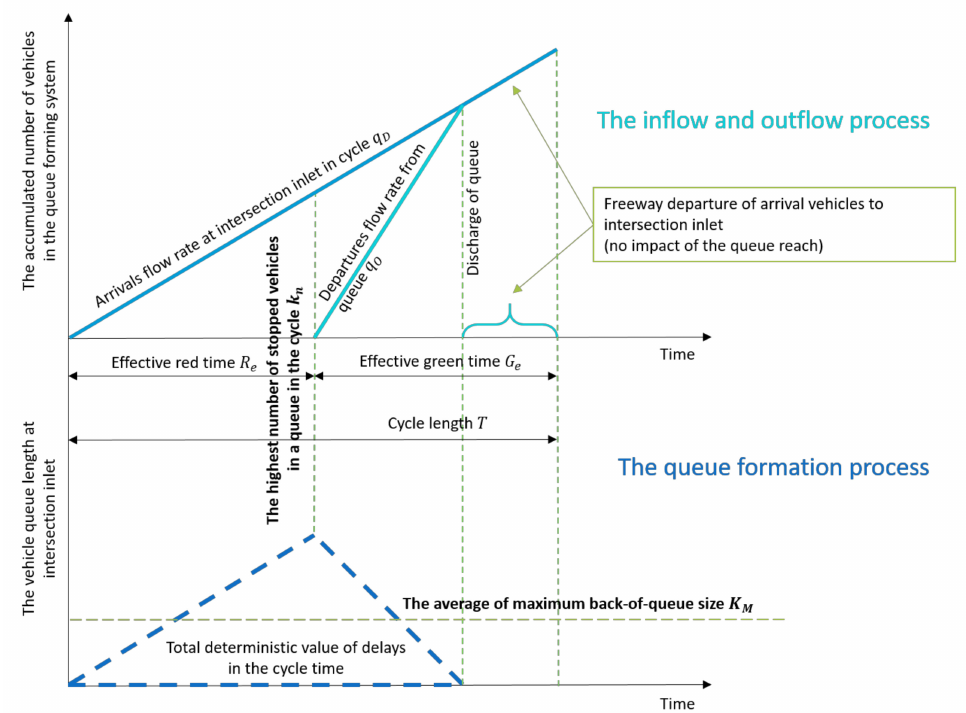
Figure 1. The idea of the modeling of delays and the back-of-queues at signal-controlled intersection approach in a typical period of vehicle service (in the period of no traffic overload). Source: Own research based on